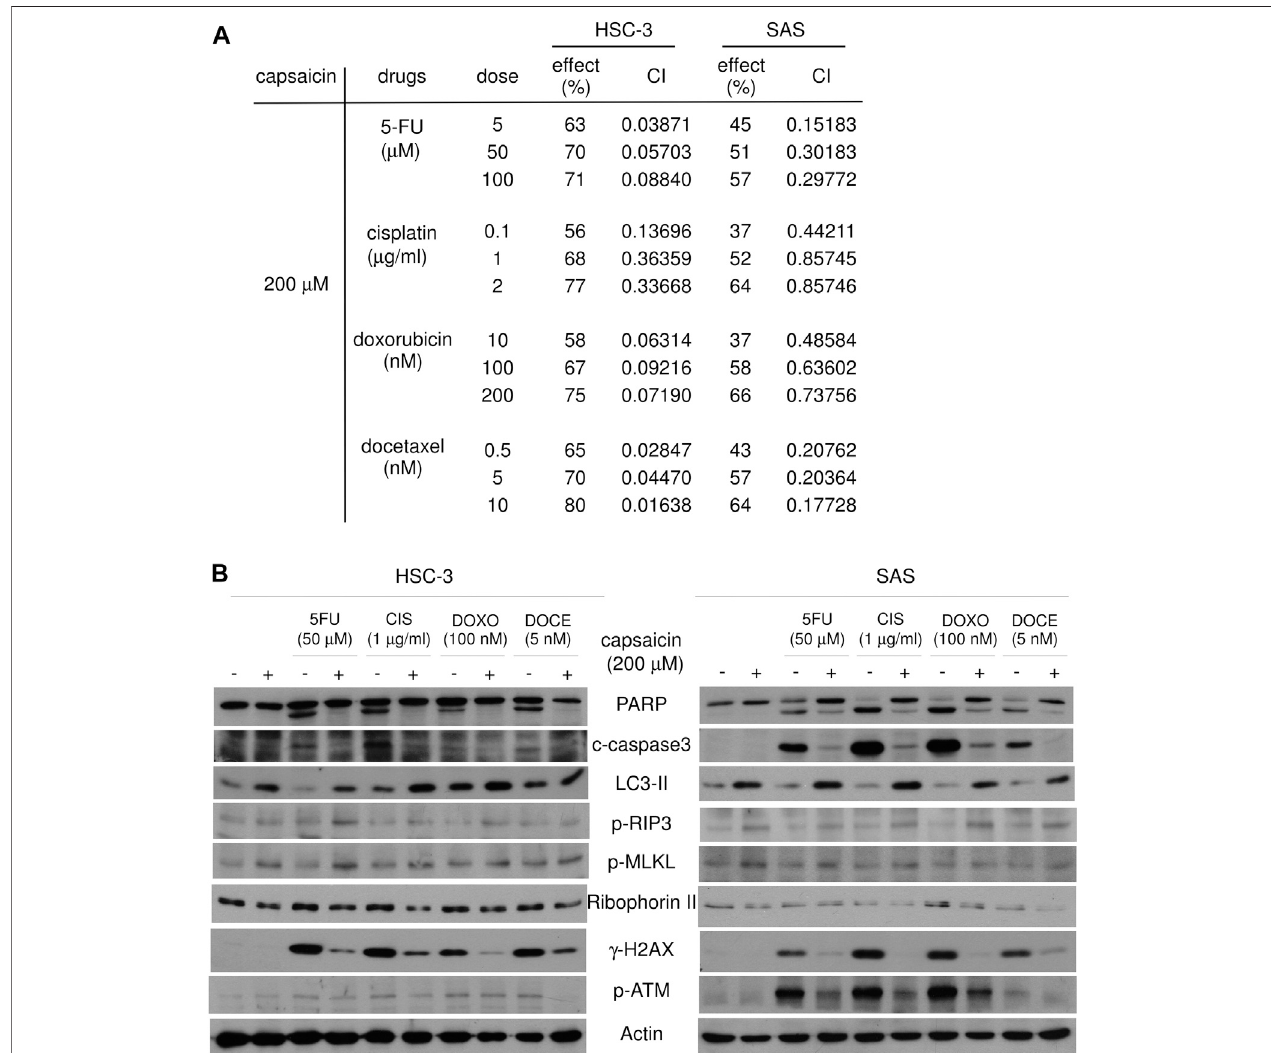
FIGURE 6 | Capsaicin plus each of four anticancer agents show synergistic effects on cell viability and induce necroptosis in HSC-3 and SAS cells. (A) Cells were cotreated with 200 μ M capsaicin and each of the listed anticancer drugs for 48 h, and cell viability was evaluated by CCK-8. The combined effect of capsaicin and anticancer drugs was evaluated using a combination index (CI)-isobologram equation that allows quantitative determination of drug interactions, as described in the Materials and Methods. (B) Cells were co-treated with 200 μ M capsaicin and each of the listed anticancer drugs for 48 h, and Western blot assays were used to examine the levels of speci fi c proteins related to apoptosis, autophagy, necroptosis, and the DNA damage responses.